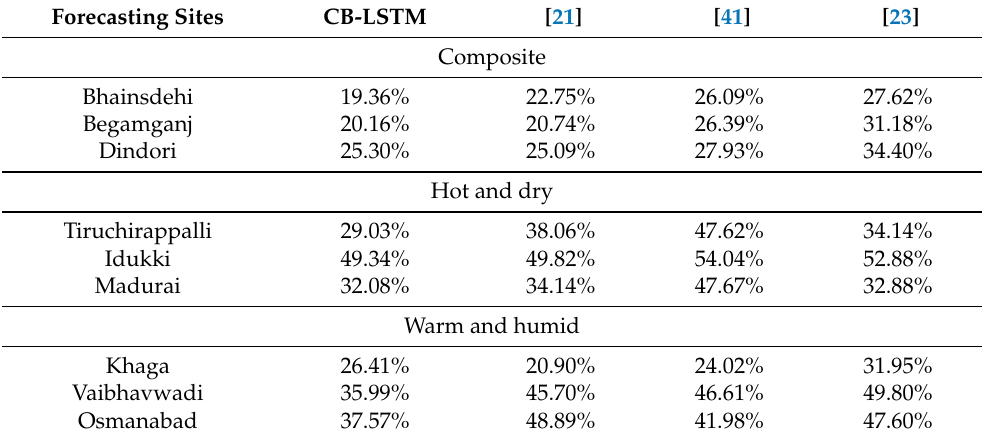
Table 8. Forecasting performance of CB-LSTM compared with benchmark models in terms of NRMSE (%). Forecasting Sites